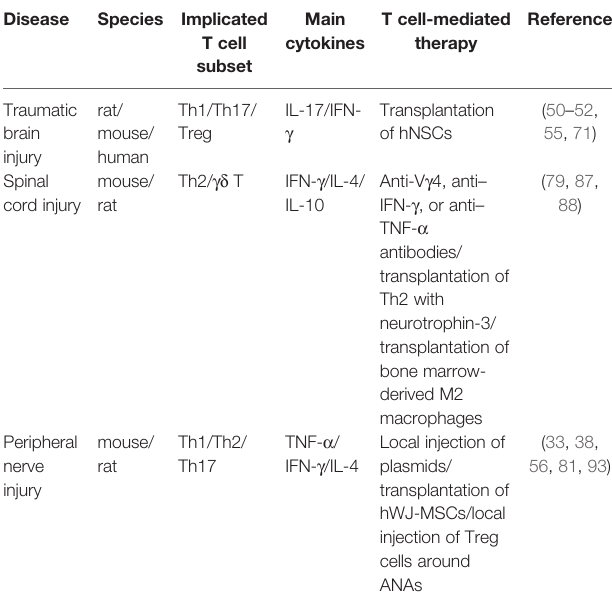
TABLE 1 | Summary of therapies based on T cells modulation for nerve